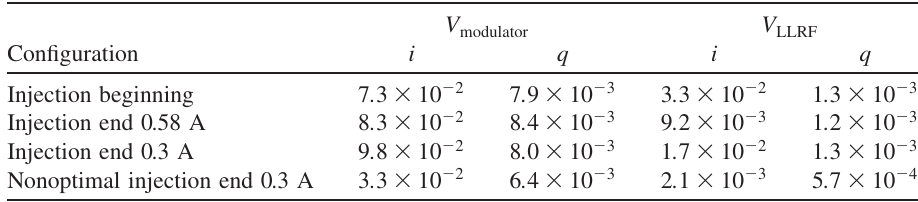
ffiffiffiffiffiffi p Hz